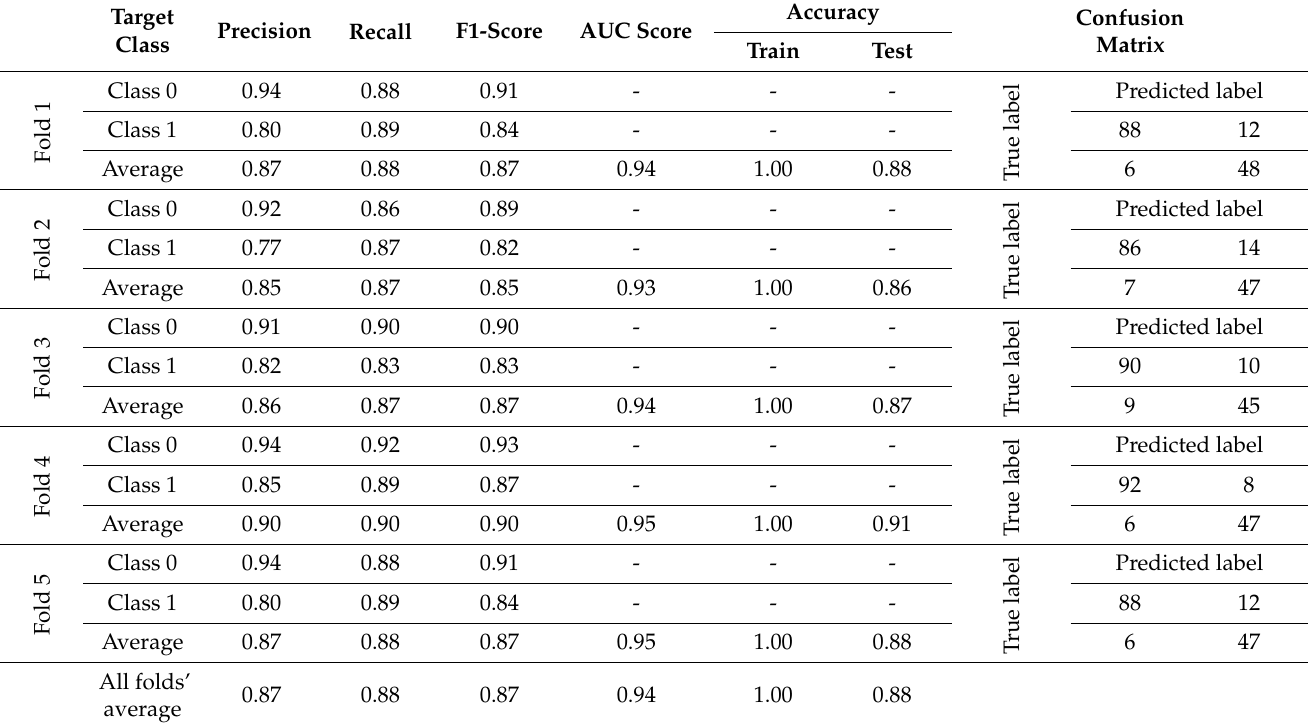
Table A4. Random forest model’s performance for the five-fold cross-validation.